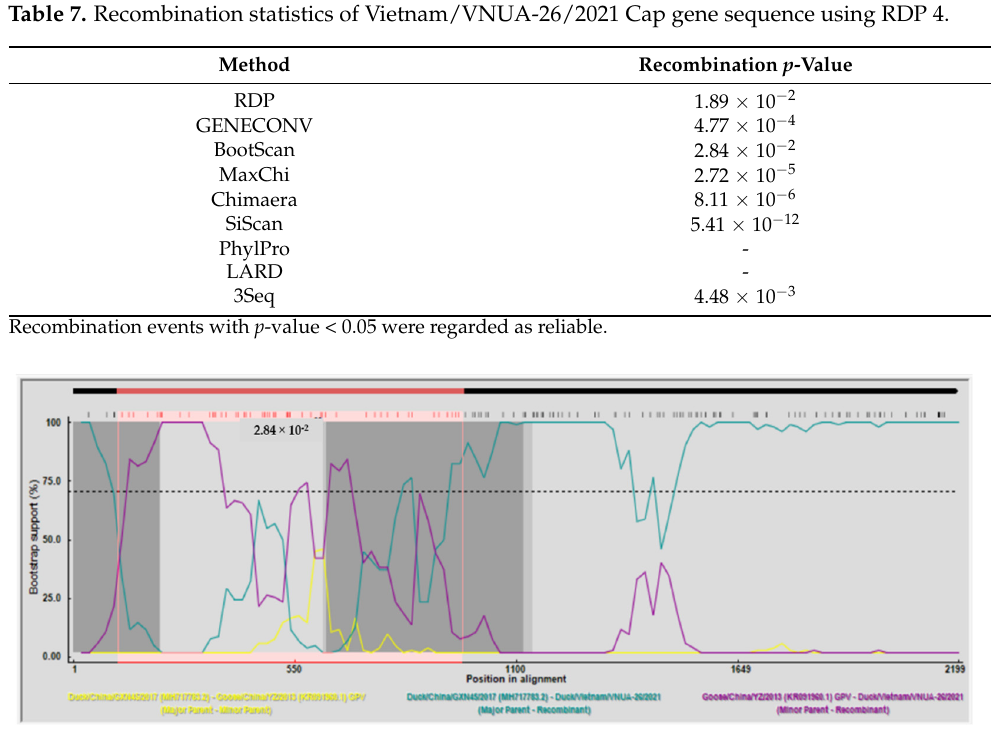
Figure 5. Detection of recombination events using BootScan analysis of full-length Cap gene se- quences of Vietnam/VNUA-26/2021 NGPV strains. The pairwise distance model with window size 200, step size 20, and 1000 bootstrap replicates was generated by the RDP 4 program.